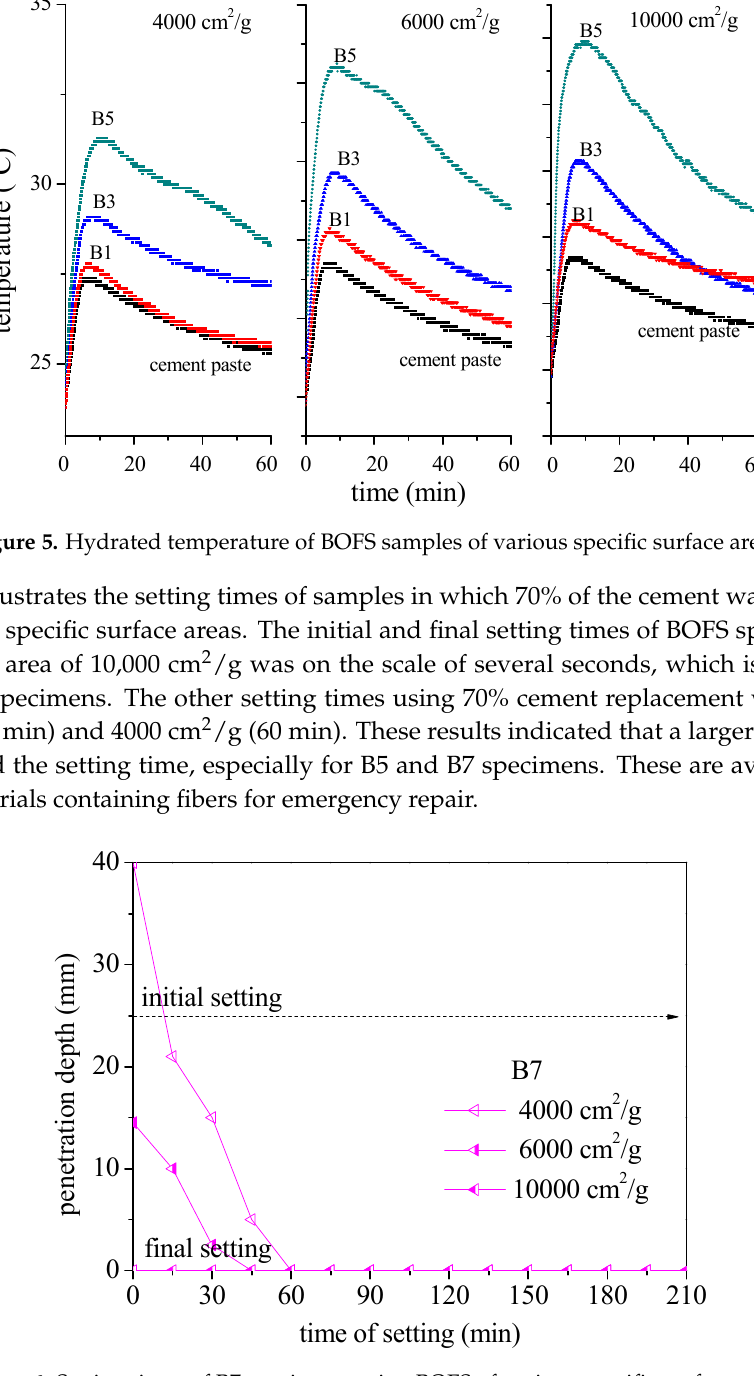
Figure 6. Setting times of B7 specimens using BOFS of various specific surface areas.